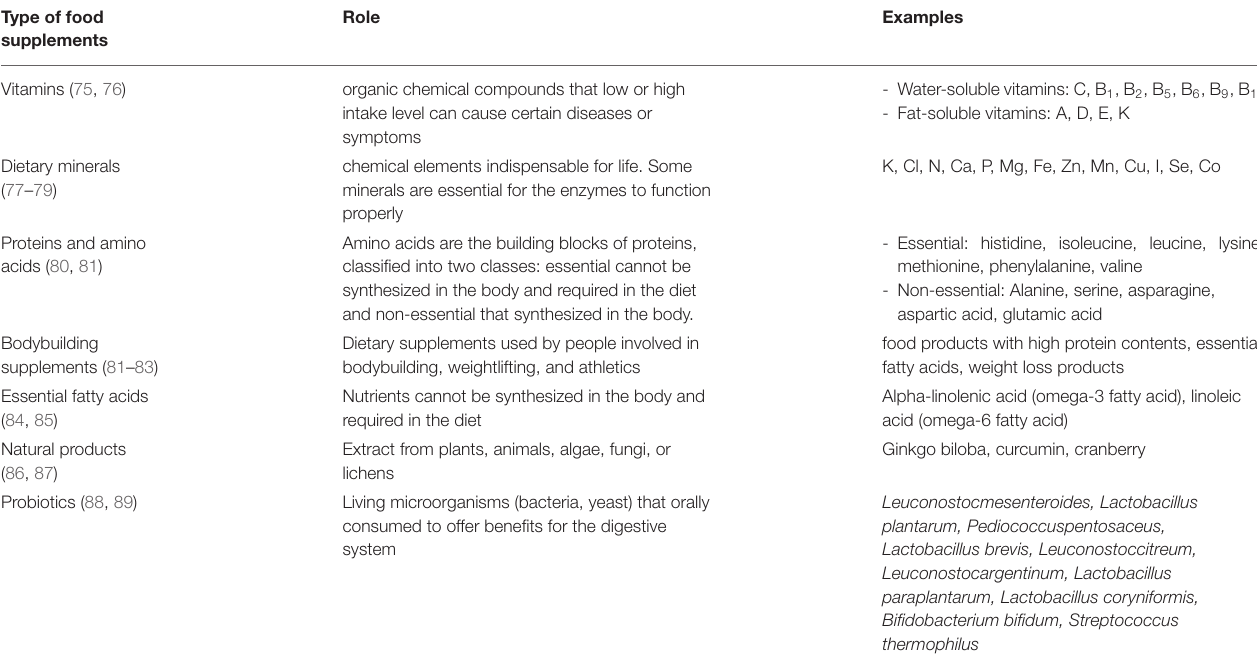
TABLE 1 | Types of food